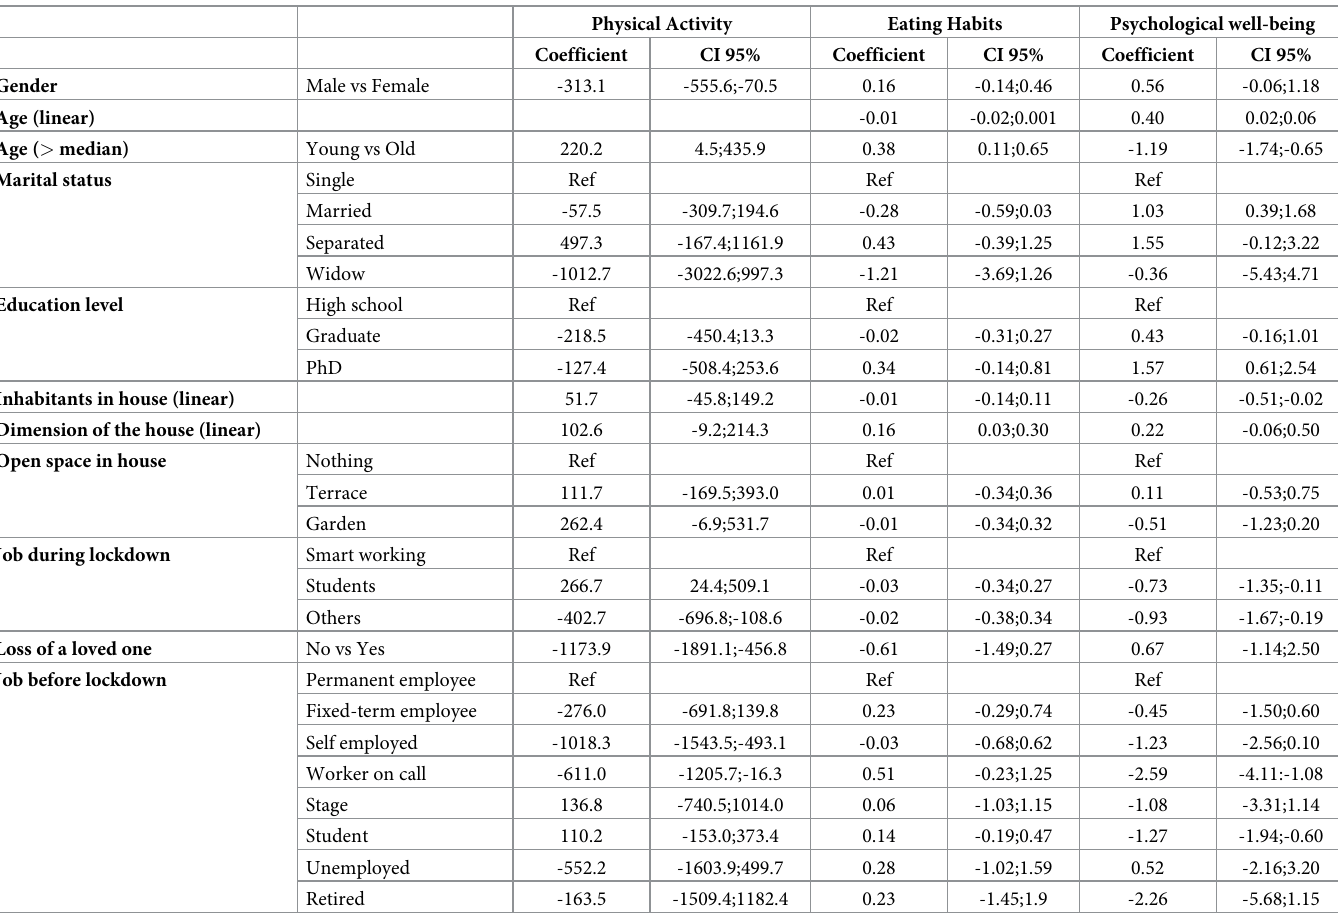
Table 4. These are the results related to the relationship between physical activity, eating habits and psychological well-being with socio-demographic variables.